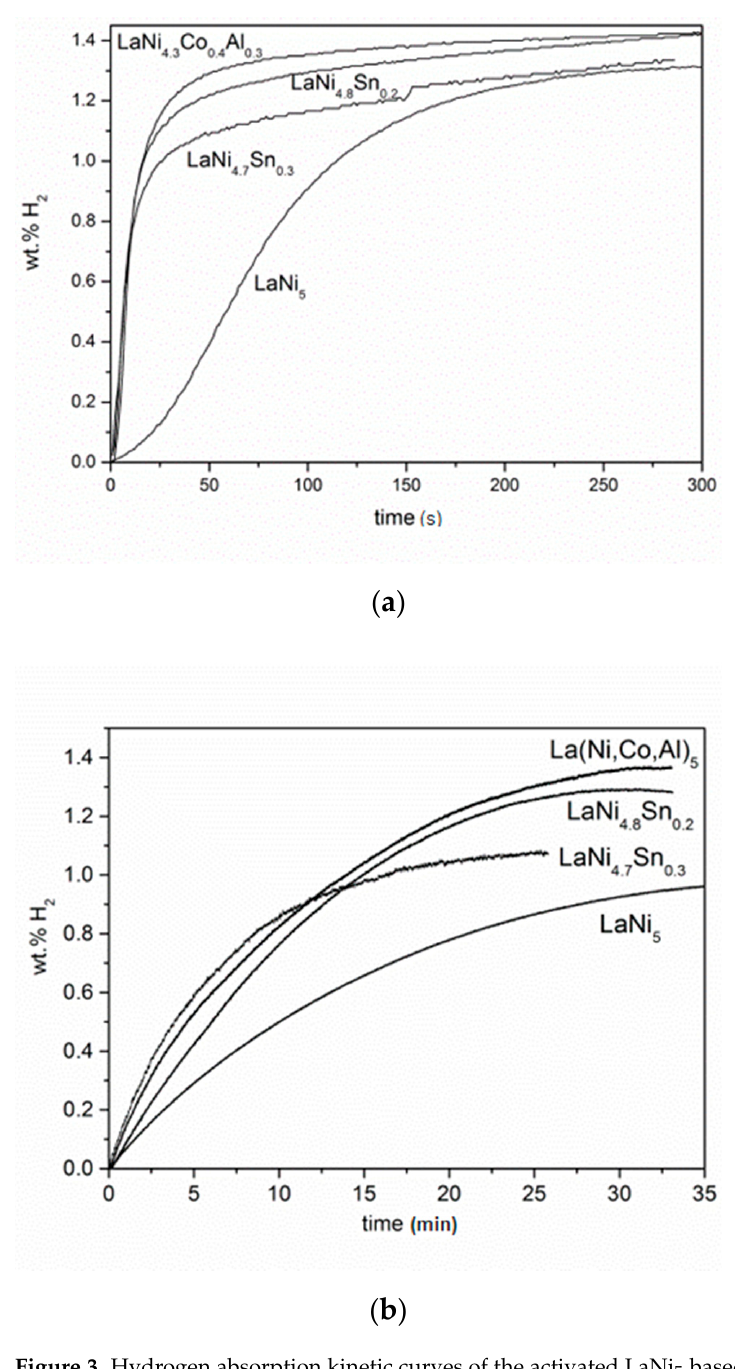
Figure 3. Hydrogen absorption kinetic curves of the activated LaNi 5 based alloys (20 °C, 10 atm) ( a ); and before activation ( b ).